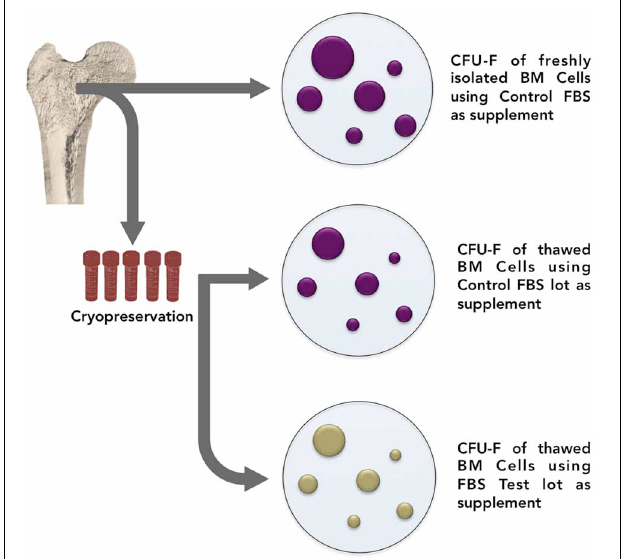
FIGURE 4 | In order to establish a “surveillance system” when working with mesenchymal progenitors isolation and expansion, it is suggested that each laboratory keep a standard collection of bone marrow samples to be used as references for testing serum lots. Conceptually, each lab could select representative bone marrow samples, split each of them into equal aliquots (10, 20, 30, or as many as possible), freeze all at the same time, and cryopreserve. These aliquots will then be thawed and used to test serum “quality” every time changes of lots are necessary. From time to time, bone marrow collection must be